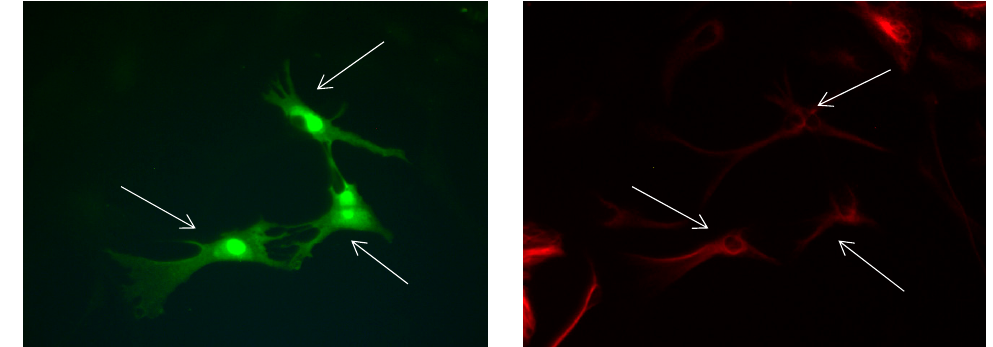
Figure 10. Cultures in a serum-free medium, 5 days (6 days after the passage): Immunofluorescence with anti-GFAP (glial fibrillary acidic protein) (red, secondary antibody: donkey anti-goat IgG Alexa Fluor 594), and with anti-Calbindin D28k (polyclonal antibody from the company SWANT) (green, secondary antibody: donkey anti-rabbit IgG Alexa Fluor 488). Epifluorescence microscopy. Three Calbindin D28k positive and GFAP-positive astrocytes (long arrows) with processes.